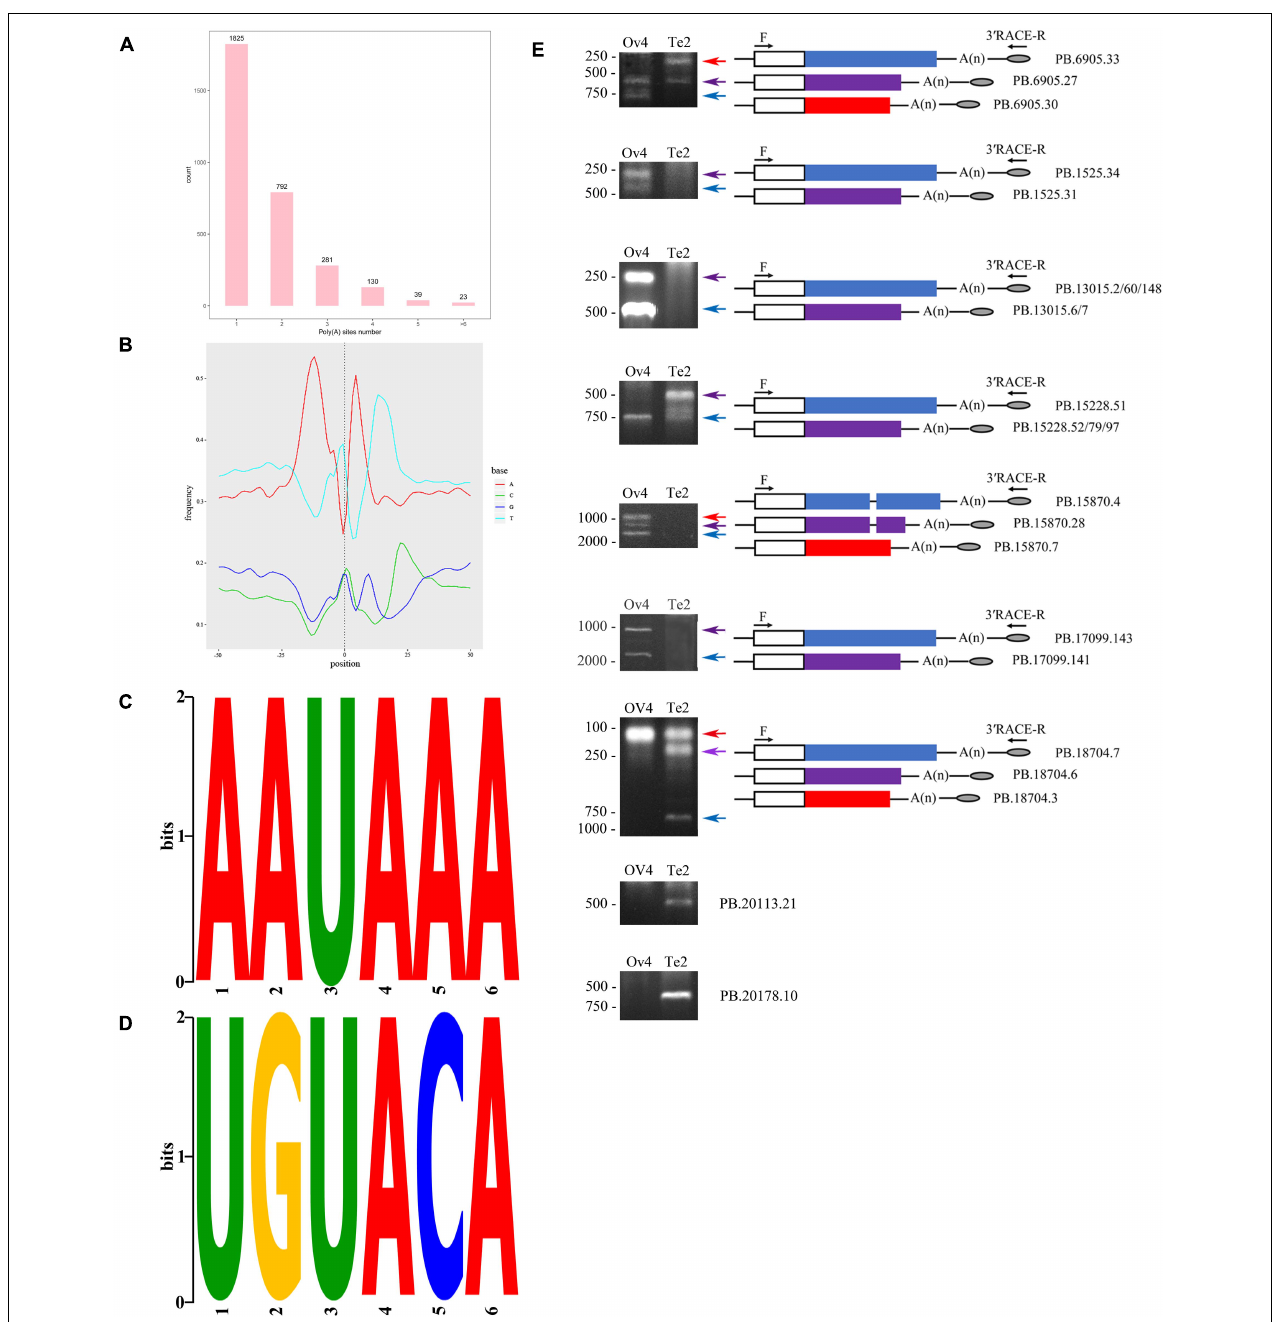
FIGURE 8 | Alternative polyadenylation analysis. (A) Result of poly (A) sites analysis using TAPIS. (B) Nucleotide bias analysis on 50 nt up- and down-stream of poly (A) sites. (C) MEME analysis identified a conserved poly (A) signal. (D) Another overrepresented motif (UGUA) is found. (E) Validation of polyadenylation sites by nest-PCR. R, 3 (cid:48) RACE reverse primer; F, gene-specific primer; consensus and specific sequence of isoforms were represented by open boxes and colored boxes,